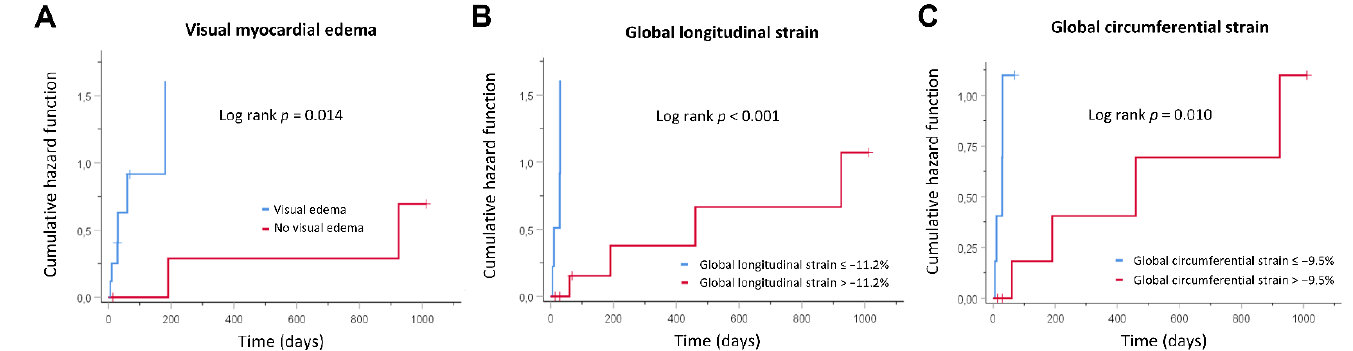
Figure 4. Kaplan – Meier curves showing cumulative hazard functions for left ventricular function recovery over time. Curves are given for ( A ) visual myocardial edema, ( B ) global longitudinal strain, and ( C ) global circumferential strain at initial presentation.